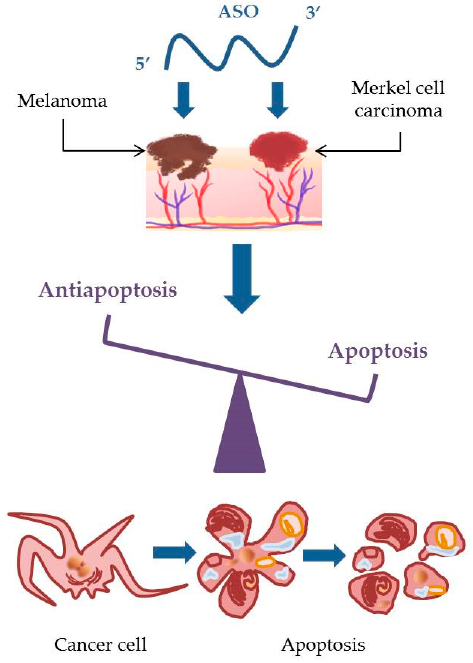
Figure 6. The effect of antisense oligonucleotides on skin cancer cells. ASO: antisense